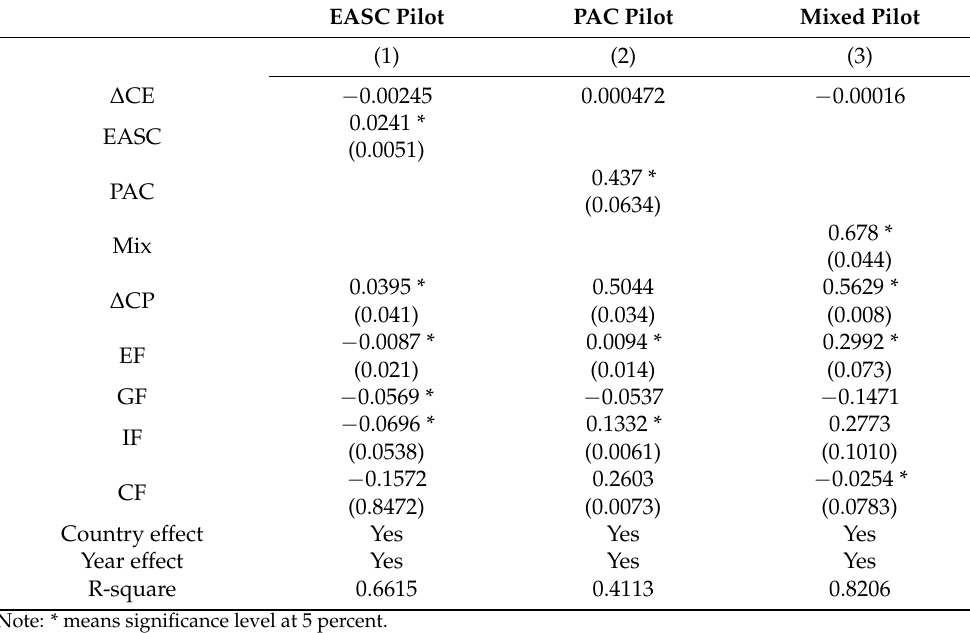
Table 6. Robustness analysis.